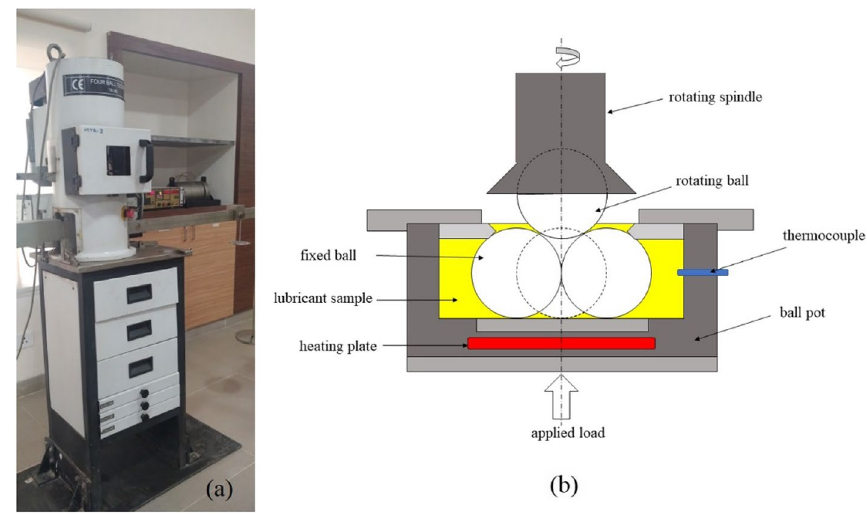
Fig. 1 a Four-ball tribometer test rig used for this investigation and b schematic representation of the four-ball